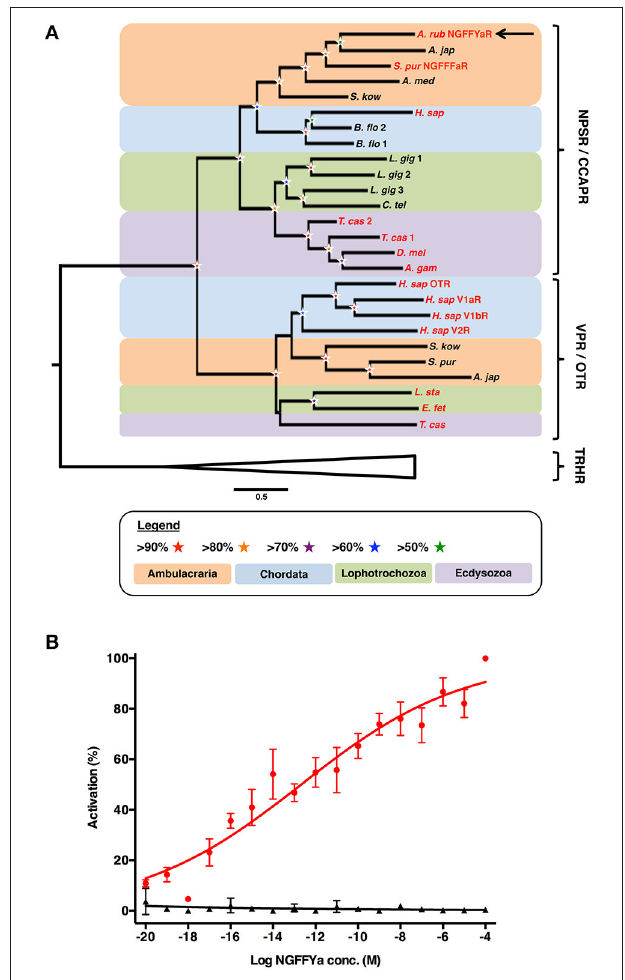
FIGURE 3 | Identification of an NPS/CCAP-type receptor in the starfish A. rubens that is activated by the neuropeptide NGFFYamide. (A) Phylogenetic tree showing that the A. rubens NPS/CCAP-type receptor (arrow) is positioned in a clade comprising NPS/CCAP-type receptors that is distinct from a clade comprising paralogous VP/OT-type receptors. Thyrotropin-releasing hormone (TRH)-type receptors were included here as an outgroup. Bootstrap support (1,000 replicates) for each clade is represented with colored stars as denoted in the key. Species in which the ligands for NPS/CCAP-type receptors and/or VP/OT-type receptors have been identified experimentally are shown with red lettering. Species: A. gam ( Anopheles gambiae ); A. jap ( Apostichopus japonicus ); A. med ( Antedon mediterranea ); A. rub (Asterias rubens) ; B. flo ( Branchiostoma floridae ); C. tel (Capitella teleta) D. mel (Drosophila melanogaster) ; E. fet ( Eisenia fetida ); H. sap ( Homo sapiens ); L. gig (Lottia gigantea) ; L. sta ( Lymnaea stagnalis ); S. kow ( Saccoglossus kowalevskii ); S. pur ( Strongylocentrotus purpuratus ); T. cas (Tribolium castaneum) . The accession numbers of sequences included in the phylogenetic tree are listed in Supplementary Table 1 . (B) Concentration-response curve showing that synthetic NGFFYamide (shown in red) activates the A. rubens NPS/CCAP-type receptor in CHO cells co-expressing the promiscuous G-protein G α 16 and over-expressing the GFP-aequorin fusion protein G5A. Control experiments where CHO cells were transfected with an empty pcDNA 3.1( + ) vector are shown in black. Each point ( ± s.e.m.) represents mean values from at least two independent experiments, with each experiment performed in triplicate. Concentration-response data are shown relative (%) to the maximal response (100% activation) observed in each experiment. The EC 50 value for activation of the NPS/CCAP-type receptor with NGFFYamide is 2.1 × 10 − 13 M.